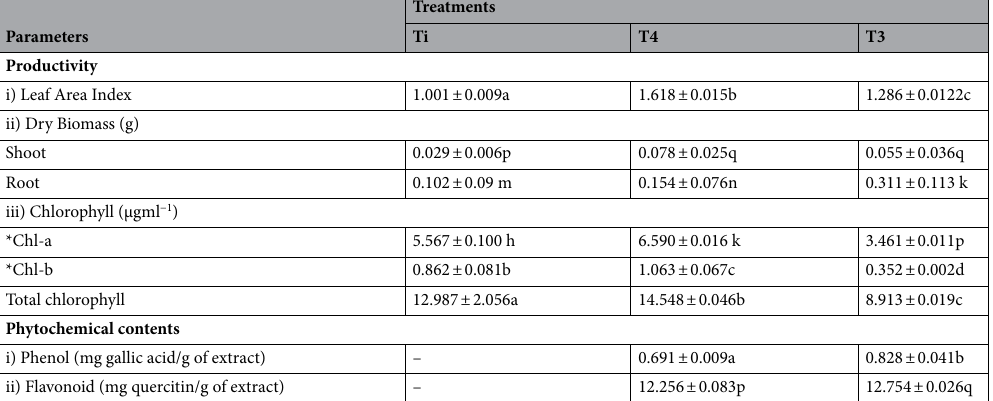
Table 3. Showing the changes in productivity parameters and phytochemical contents of Cyperus brevifolius. Mean value ± SD, n = 3; the different letters within the same row represent the significant differences of the values (ANOVA, LSD test, Paired t-test, P < 0.05 ). Ti- seedlings of Cyperus brevifolius grown in soil bed initially for the experiment; T4- Non-contaminated soil + Cyperus brevifolius ; T3- Crude oil